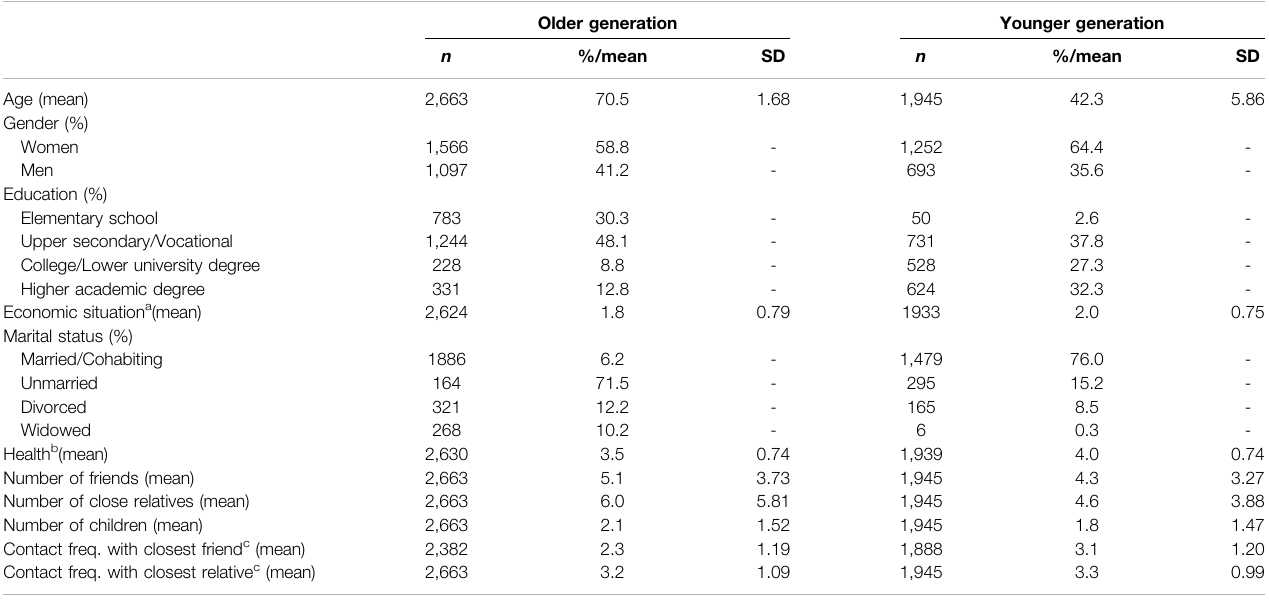
TABLE 1 | Descriptive statistics ( n and